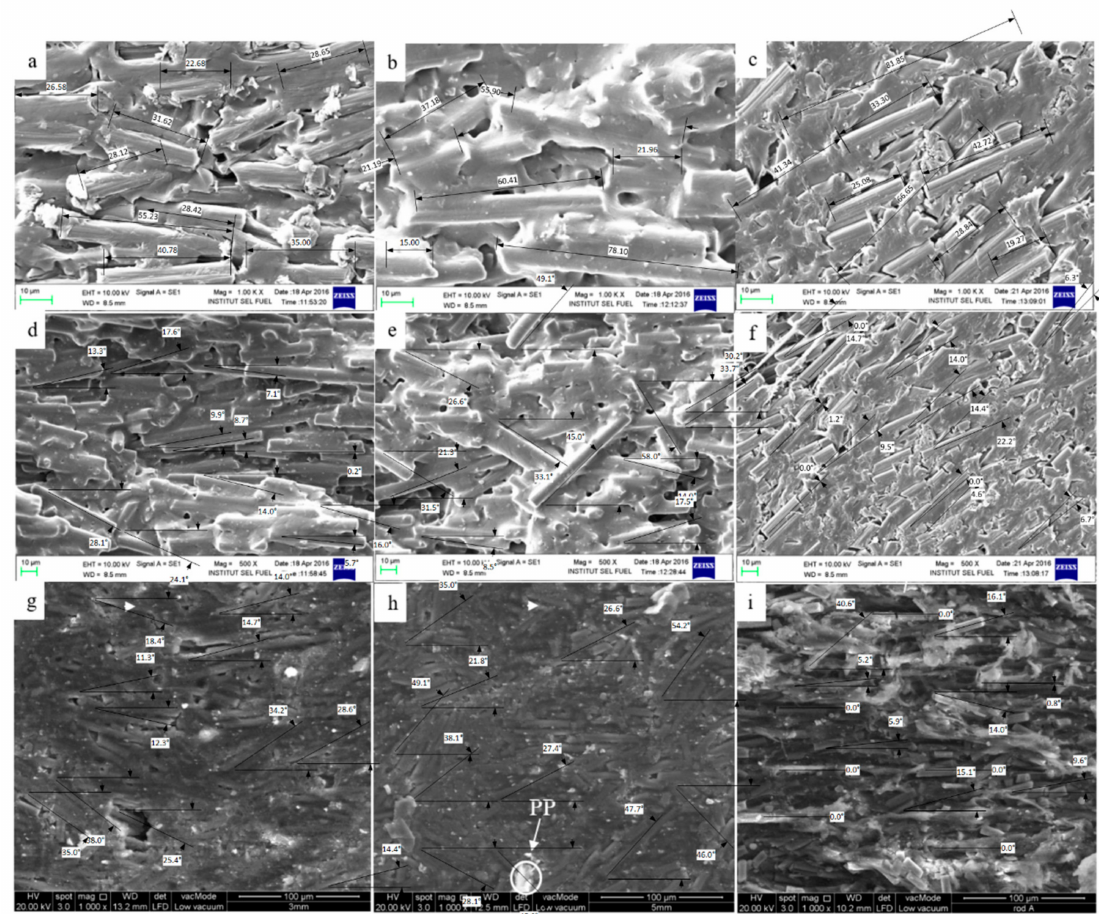
Figure 4. SEM images of extruded MCF/PP using 1.00 K × magnification of ( a ) 3 mm thick sheet die; ( b ) 5 mm thick sheet die; ( c ) 5 mm diameter rod die, 500 × magnifications of ( d ) 3 mm sheet die; ( e ) 5 mm sheet die and ( f ) 5 mm diameter rod die and compressed MCF/PP using 1.00 K × magnification of ( g ) 3 mm thick sheet die; ( h ) 5 mm thick sheet die; ( i ) 5 mm diameter rod